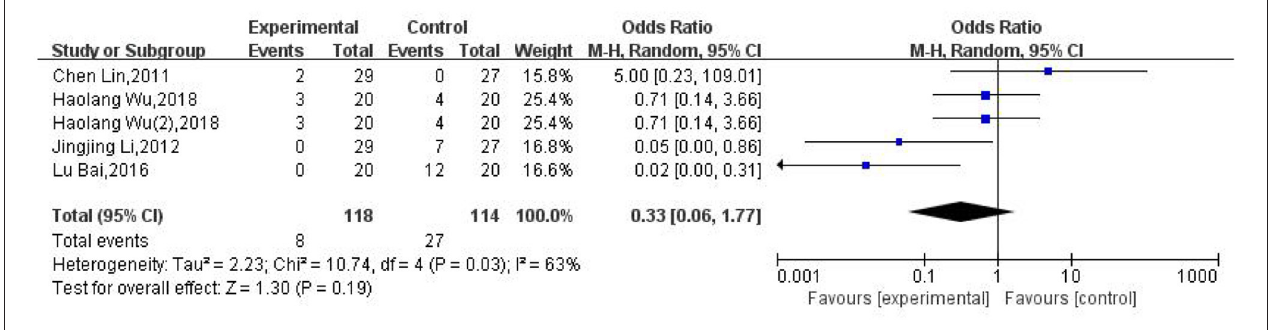
FIGURE 8 | Meta-analysis of adverse events.